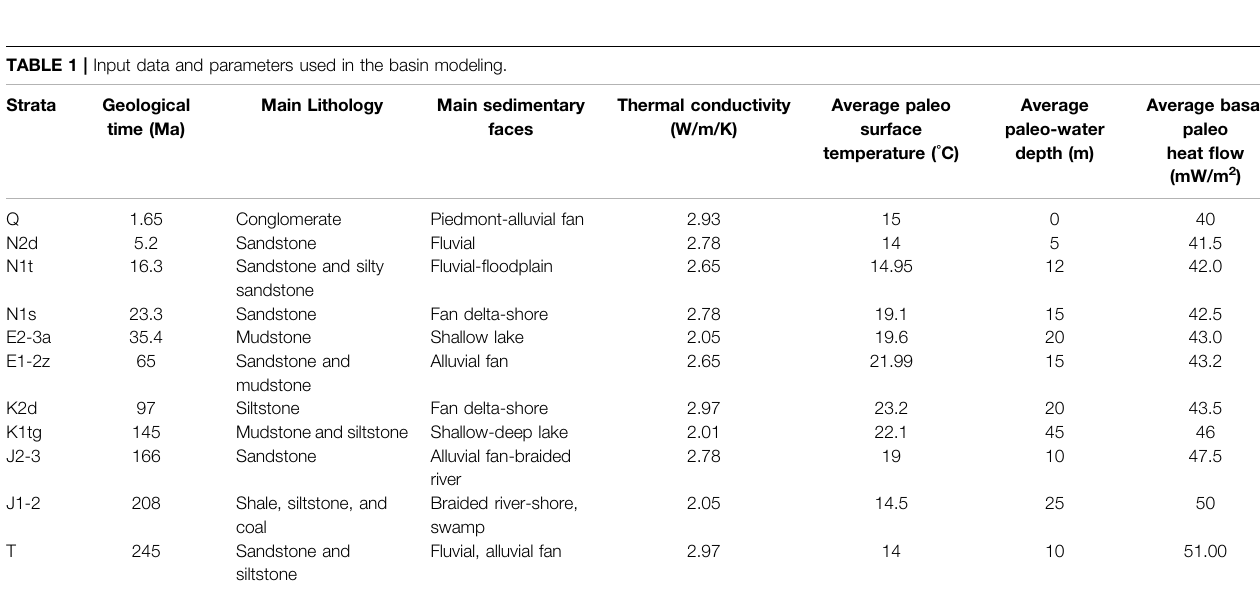
FIGURE 6 | Plot of δ 13 C 1 versus δ 13 C 2 for natural gas from the South Junggar foreland basin, showing gas derived from different maturity.